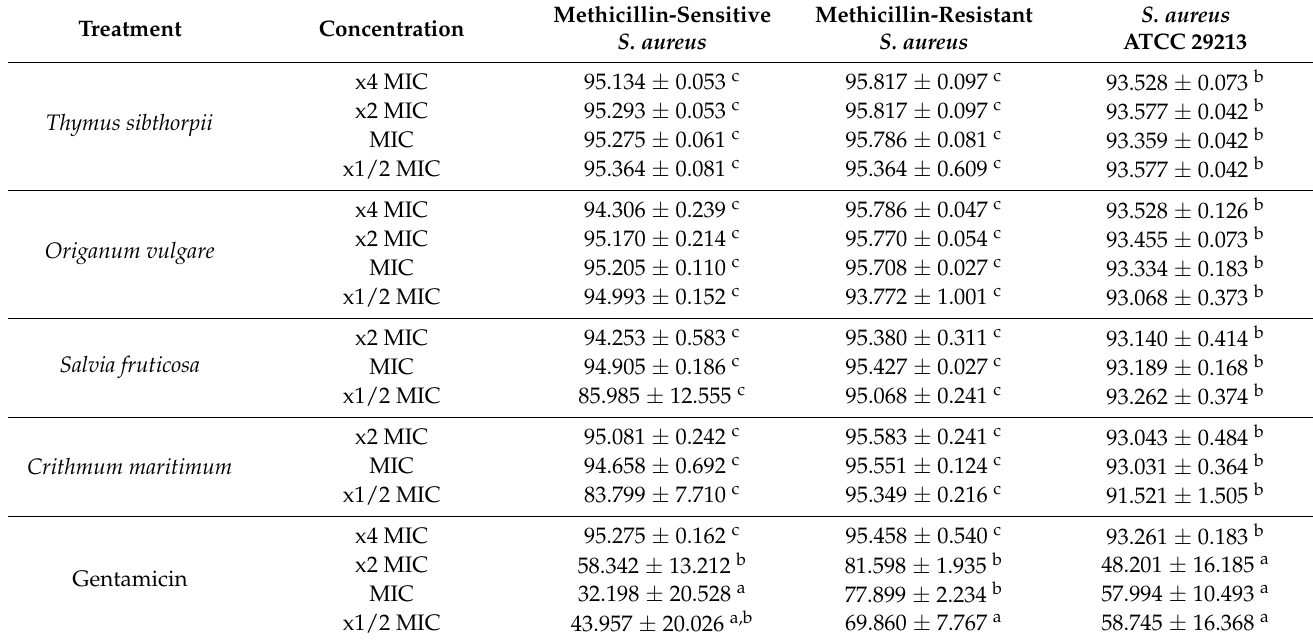
Figure 2. Comparison of biofilm formation ability of MSSA, MRSA, S. aureus ATCC 29213 (S. aureus), S. epidermidis ATCC 12228 (S. epidermidis (-)), and S. epidermidis ATCC 35984 (S. epidermidis (+)) regarding their OD values with negative control (TSBG medium only). Each value represents the mean of triplicate experiments with standard deviations (Tukey, p ≤ 0.05). Table 3. Biofilm formation inhibition percentages of different concentrations of essential oils and different concentrations of reference antibiotics on treating microorganisms. Each value represents the mean of triplicate experiments with standard deviations. Different superscripts (a–c) in the row differ significantly for each strain (Tukey, p ≤